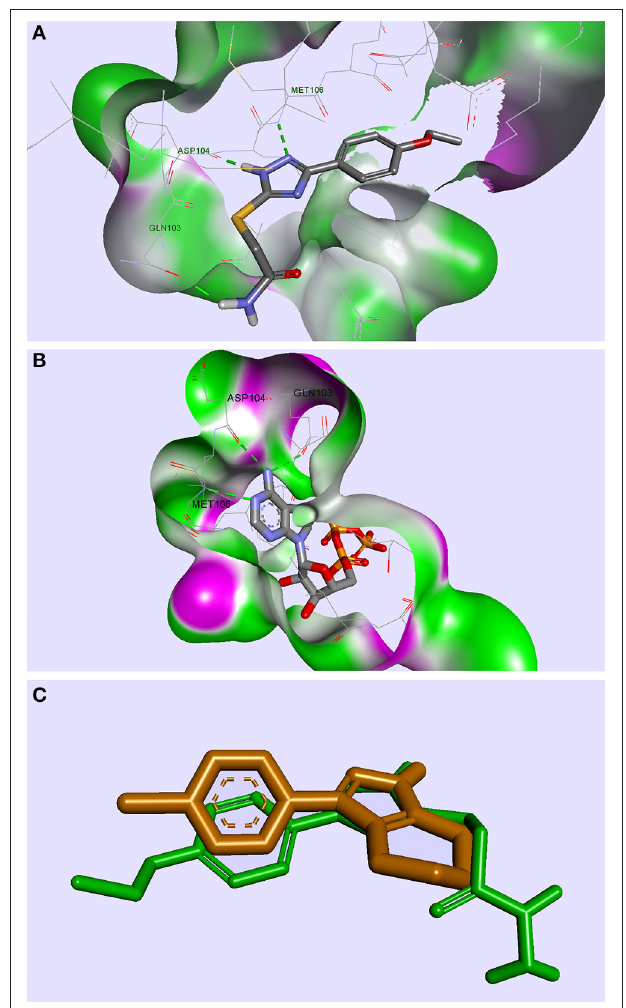
FIGURE 4 | Compound TZ53.3 docked in the ATP active site of the ERK2 protein, PDB ID: 4G6N (A) ; ERK2 protein co-crystalized with ATP molecule, PDB ID: 4GT6 (B) ; superimposed structures of compound TZ53.3 and the co-crystalized ligand of ERK2, PDB ID: 4G6N (C) ; HBs are depicted as green dotted